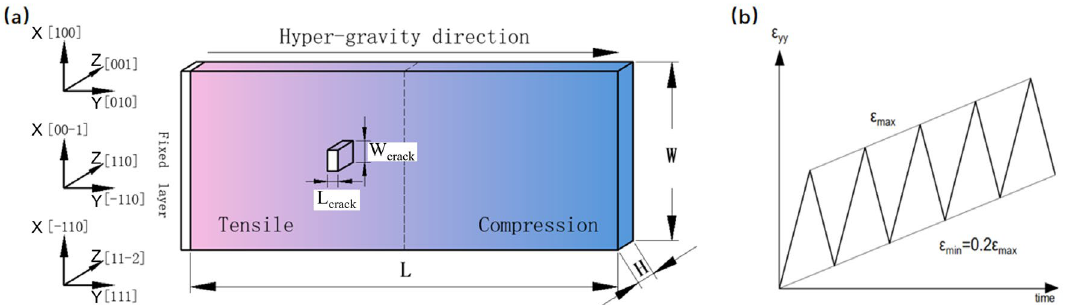
Figure 1. ( a ) Atomic model of the pre-existing center crack, in which the arrow indicates the hyper- gravity direction; ( b ) strain–time scheme for cyclic deformation.